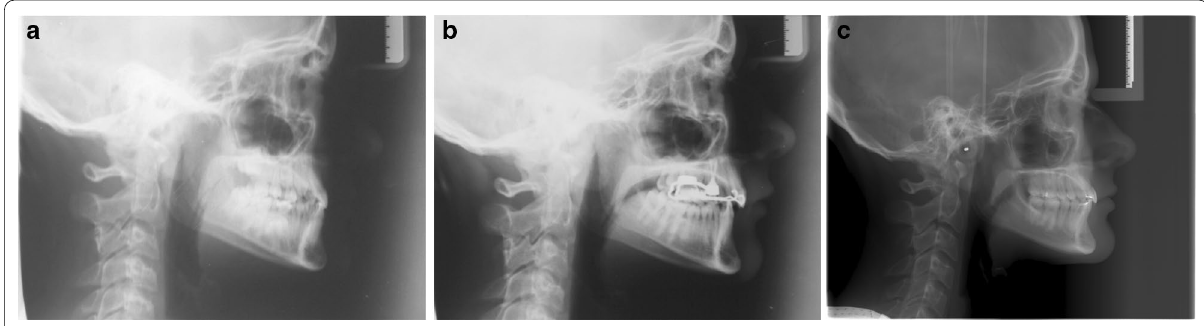
Fig. 5 a – c Lateral X-rays of one patient of the study group at T0, T1, and